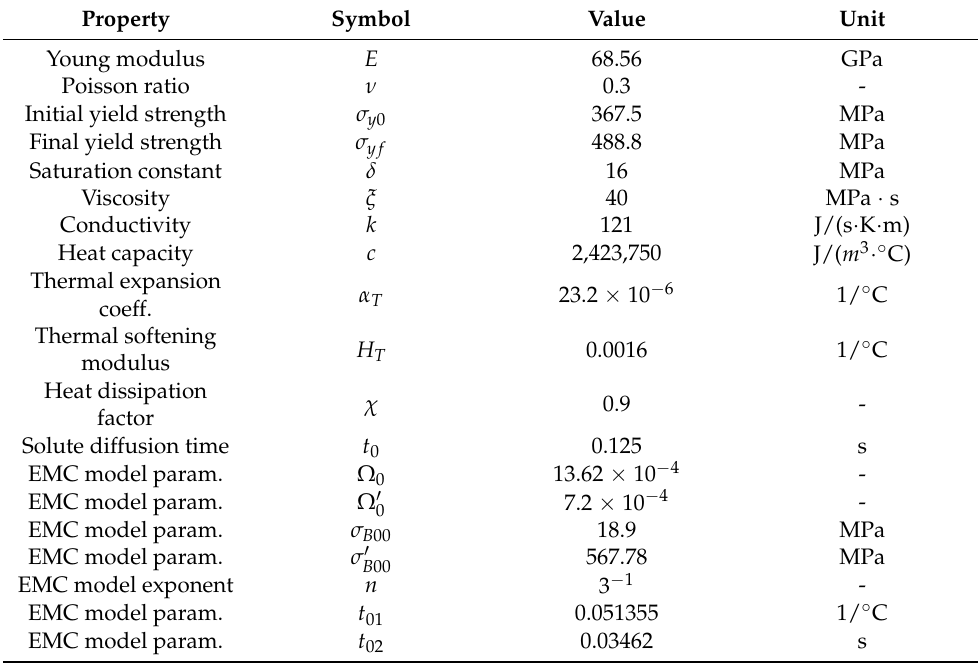
Table 1. Basic set of mechanical, thermal and McCormick model